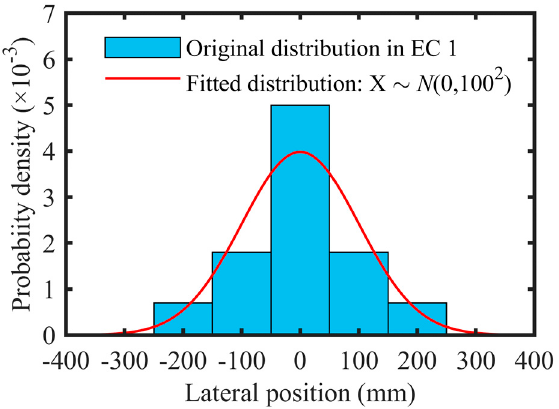
Figure 6. Probability distribution of the lateral position of vehicles.